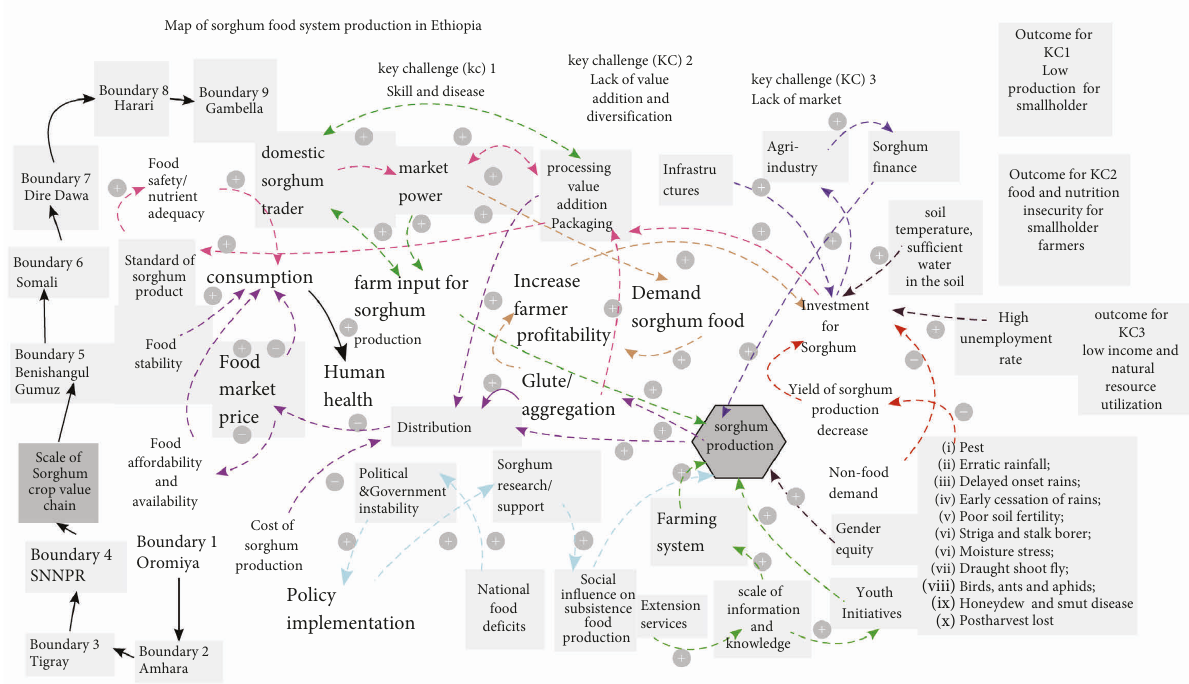
Figure 4: Causal loop and system dynamics relationship map for sorghum production, concept ideas from [36] Source: Authors’